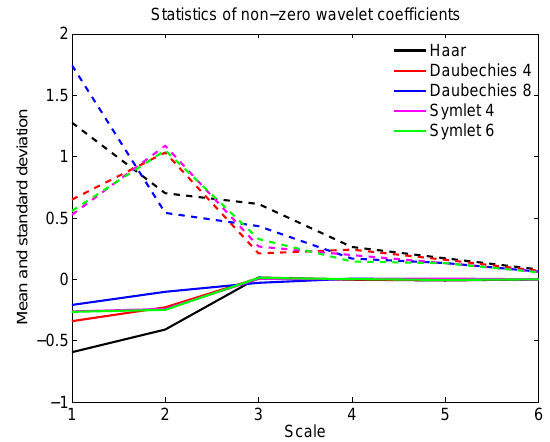
Figure 3. We plot the average value of the non-zero coefficients (solid lines) and their standard deviation (dashed line), at different scales s , when f V is subjected to wavelet transforms using Haar, Daubechies 4 and 6, and Symlet 4 and 6 wavelets. We find that while Haar may provide the sparsest representation (Fig. 2), the non-zero values tend to be large and distinct.